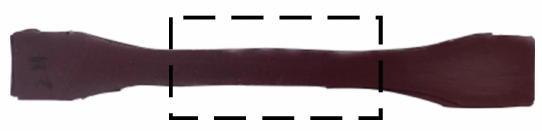
Figure 9. Adhesive film scanning